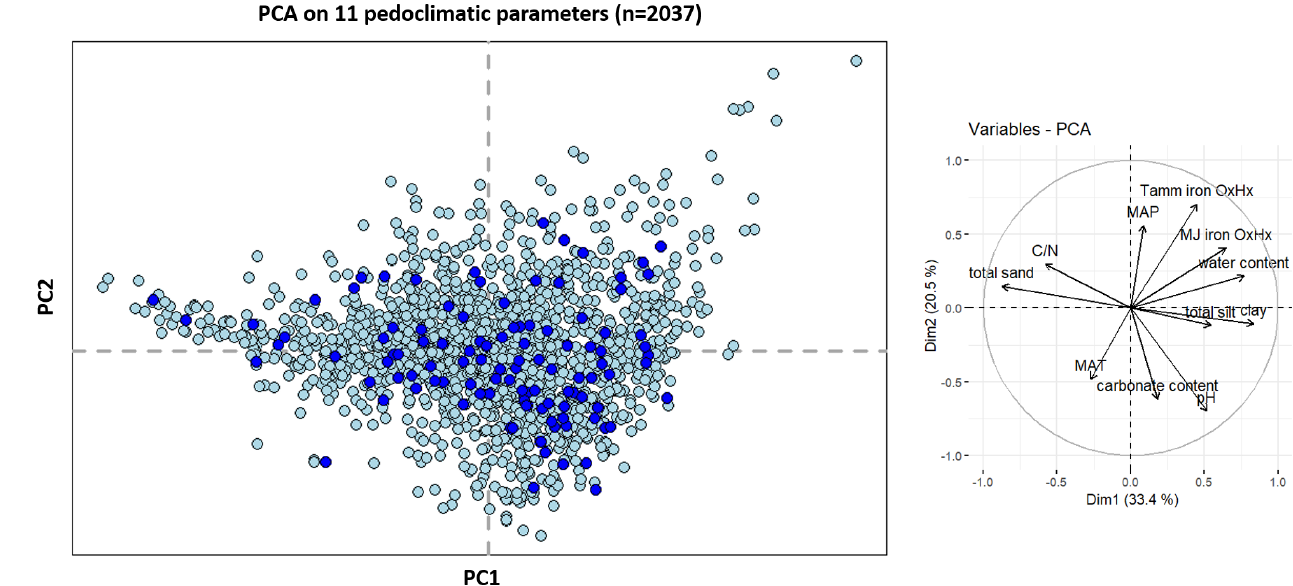
Figure A2. Score of the 2037 samples on axes 1 and 2 of the principal component analysis on 11 pedoclimatic parameters: clay, total silt and total sand contents, pH in water, water content, carbonate content, mean annual temperature, mean annual precipitation, Tamm and Mehra–Jackson iron oxyhydroxide contents, and the C / N ratio for the RMQS topsoil (0–30cm) samples. Samples with an organic carbon yield between 0.7 and 1.3 are plotted in light blue, whereas samples with an organic carbon yield < 0 . 7 or > 1 . 3 are plotted in dark